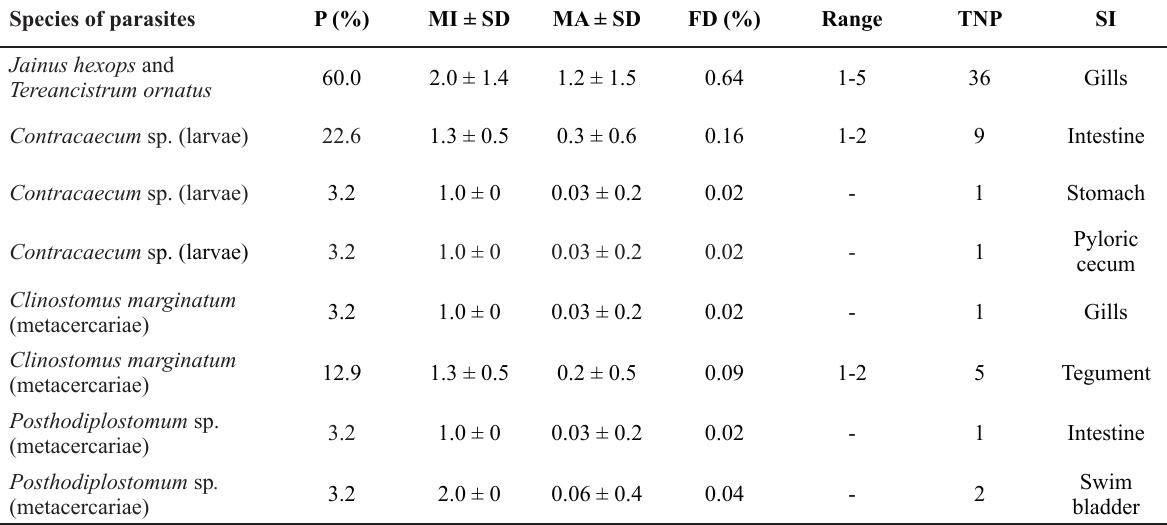
Metazoan parasites of Hemibrycon surinamensis from the Matapi River, in Amapá State, Brazil. P: Prevalence, MI: Mean intensity, MA: Mean abundance, FD: Frequence of dominance, TNP: Total number of parasites, SI: Site of infection, SD: Standard